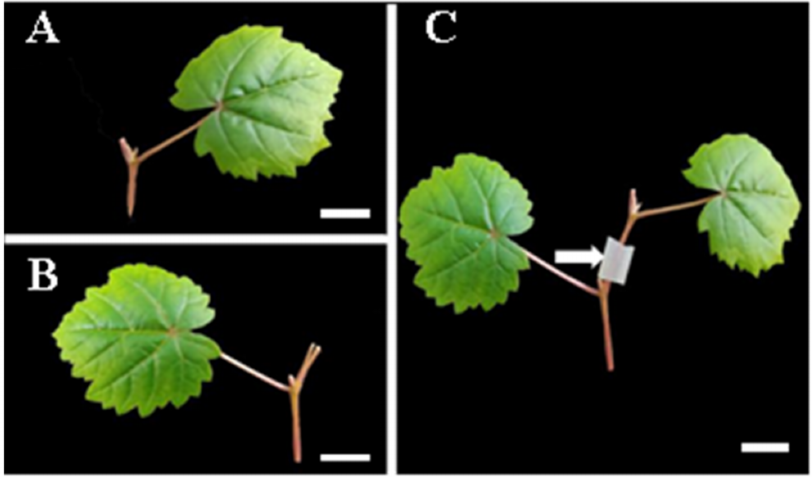
Figure 1. Micrograft development of GLRaV-3-infected in vitro scions of ‘Cabernet Sauvignon’ grapevine grafted onto healthy ‘Chardonnay’, ‘Thompson seedless’ and ‘Hunan-1’ in vitro plants as the rootstock. ( A ) Scion. ( B ) Rootstock. ( C ) Micrograft. Bars = 0.5